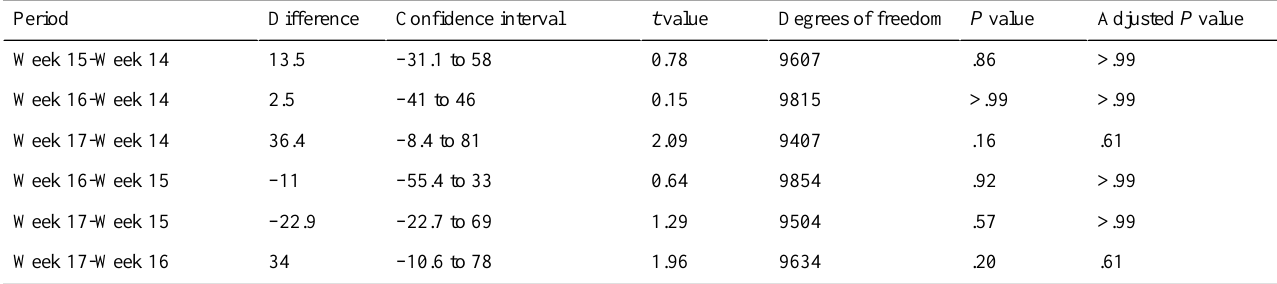
Table 6. Comparisons between weeks in the Active COVID-19 period (2020) for common